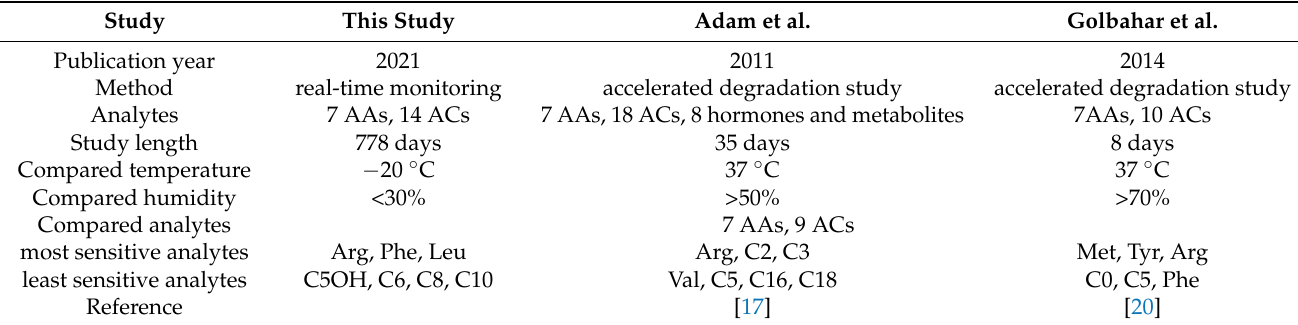
Table 4. Comparison between real-time monitoring and accelerated degradation